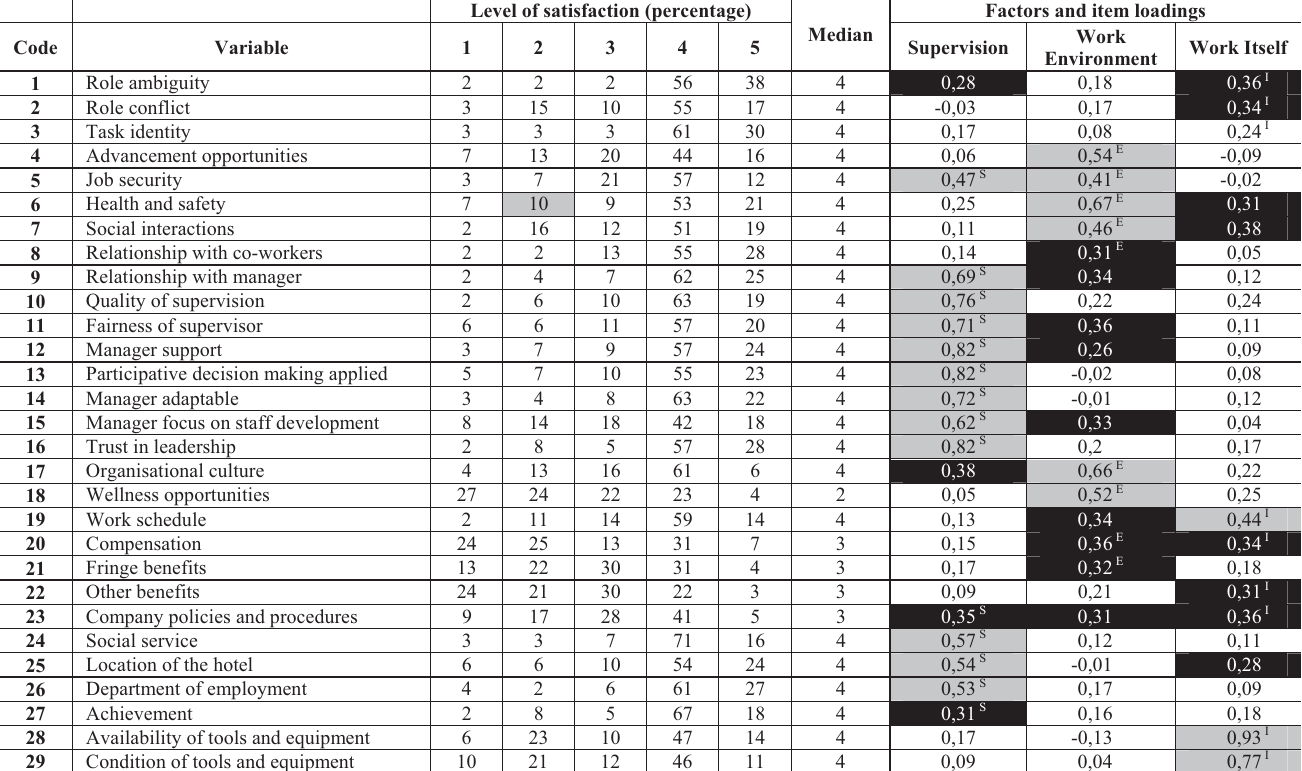
Table 2: Statistical analysis (Factor solution: maximum likelihood with orthogonal rotation) Level of satisfaction